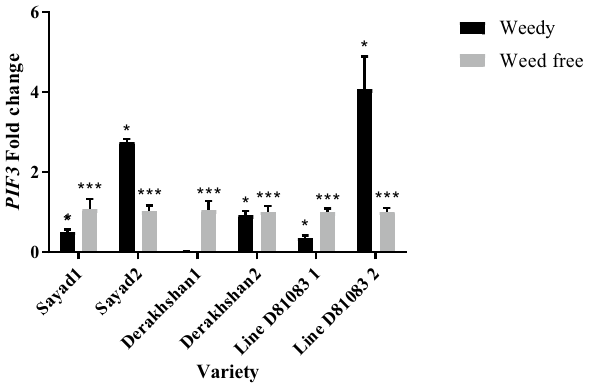
Figure 5. Real-time PCR (qRT-PCR) analysis of PIF3 gene transcript levels in two treatments weedy and weed free, in the three cultivars/lines studied and in two stages of sampling V4 and R7 (data are the mean ± standard error in five biological replications and five technical replications, numbers 1 and 2 next to the name of the cultivar represent the V4 and R7 stages, respectively). ***: P < 0.99; **: P < 0.90.